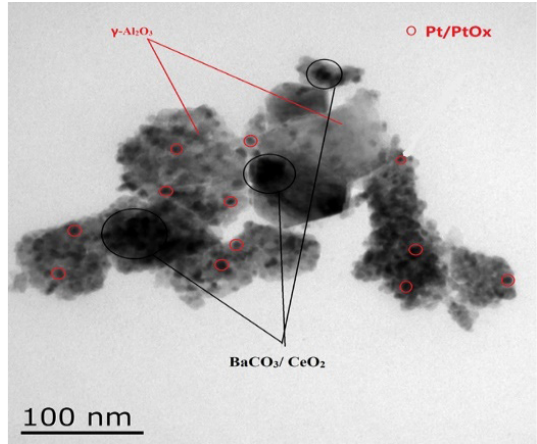
Figure 3: TEM pattern of catalyst.